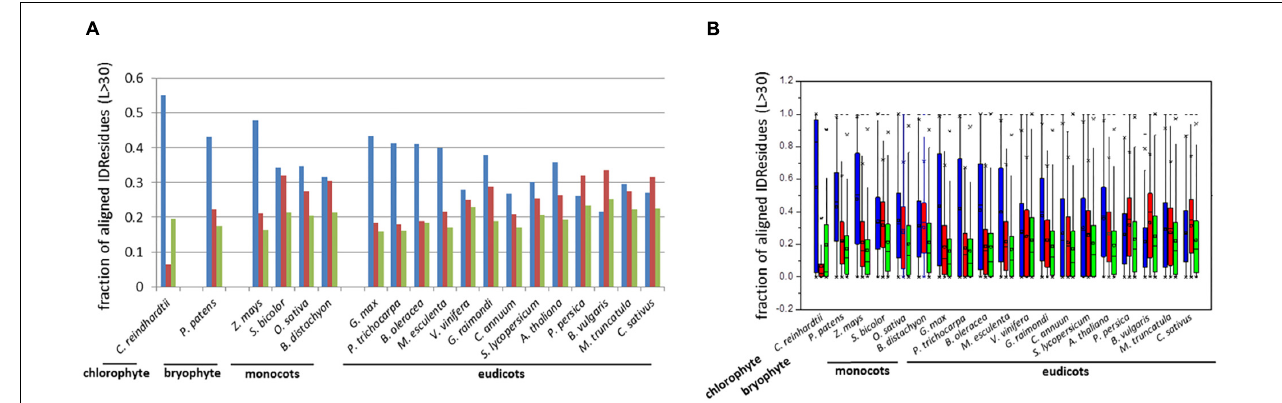
FIGURE 2 | Bar-plot of the fraction (A) and box-plot distribution (B) of aligned residues in ductile regions ( L > 30 aa). Identical IDRs (blue), similar IDRs (red), and variable IDRs (green) based on PONDR VSL2b predictions.